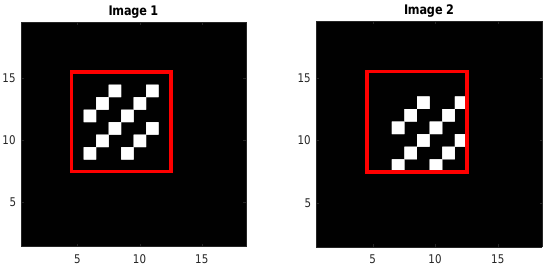
Figure 3. Two synthetic images of 18 × 18 pixels. The intensity is 1 at the darker pixels and 10 at the brighter pixels, The template (ROI) is selected as the red square window of 8 × 8